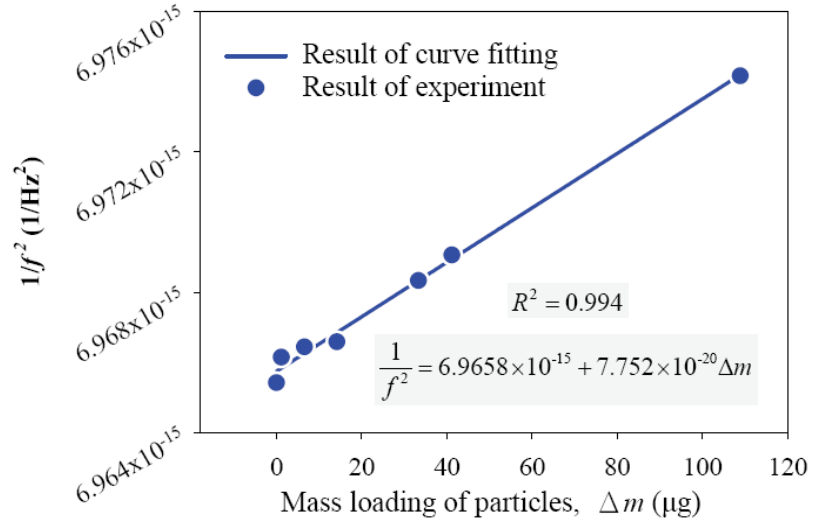
Figure 10. The measured characteristic function of the QCM